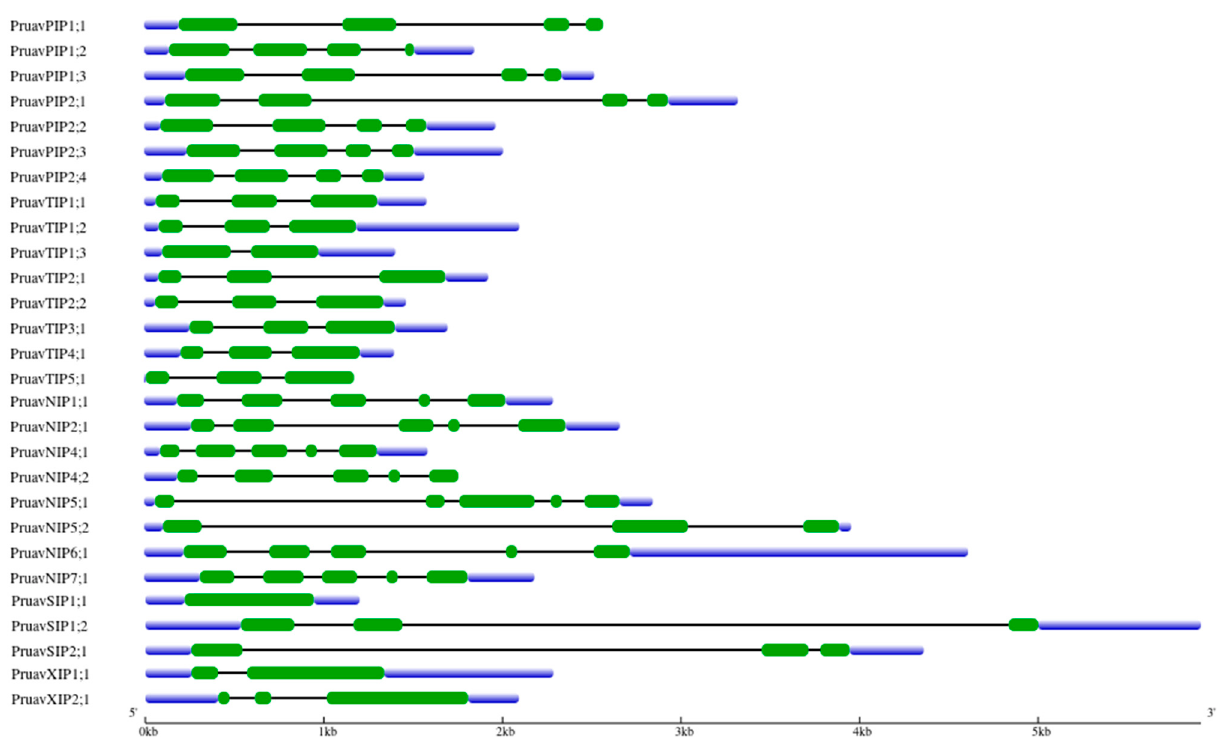
Figure 4. Exon–intron structure analysis of 28 P. avium aquaporins. Green rectangles represent exons. Blue rectangles represent the 5 ′ and 3 ′ UTR. Lines represent introns.